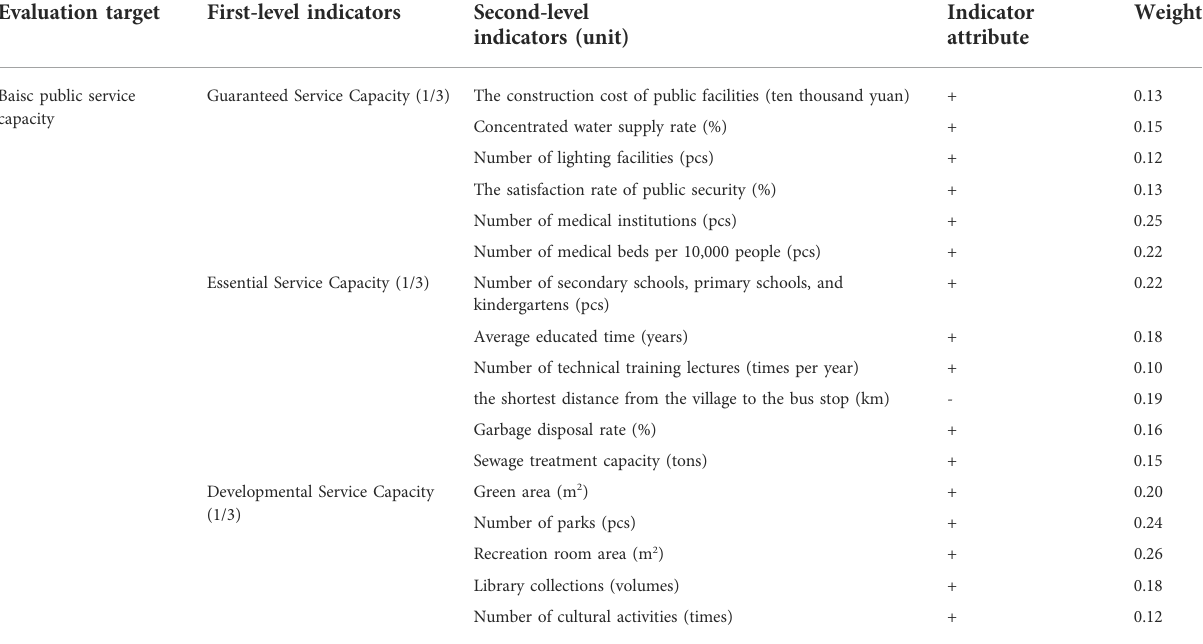
TABLE 1 Evaluation index system of basic public service